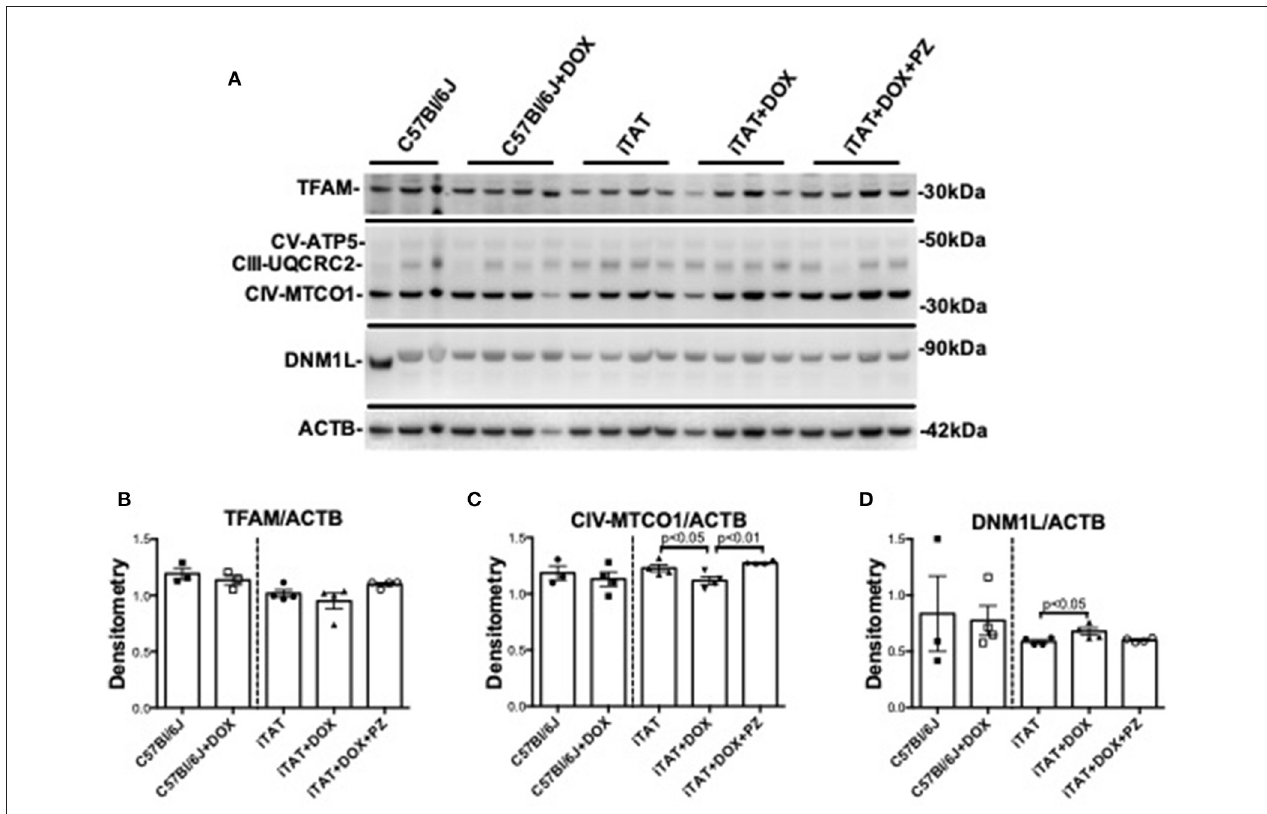
FIGURE 4 | Mitochondrial proteins in mouse sciatic nerve. (A) Representative immunoblot for TFAM, proteins of oxidative phosphorylation complexes III, IV, and V, DNM1L and ACTB. (B) Densitometric analysis of TFAM normalized to ACTB. (C) Densitometric analysis of complex IV(MTC01 sub-unit) protein normalized to ACTB. (D) Densitometric analyses of DNM1L protein normalized to ACTB. Data are mean + SEM of N = 3 for C57Bl/6J group and N = 4/group for remaining groups. Statistical analyses by unpaired test or one-way ANOVA with Tukey’s post-hoc